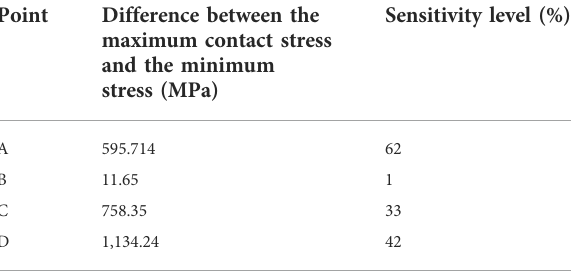
TABLE 5 Rate of increase of contact stress at